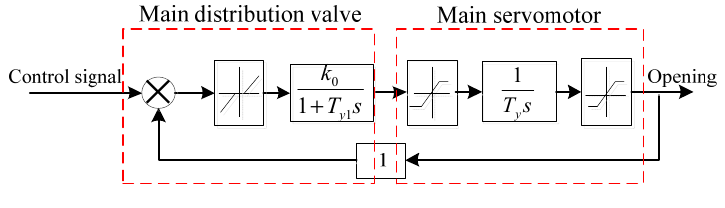
Figure 6. Structure of the servo-mechanism.